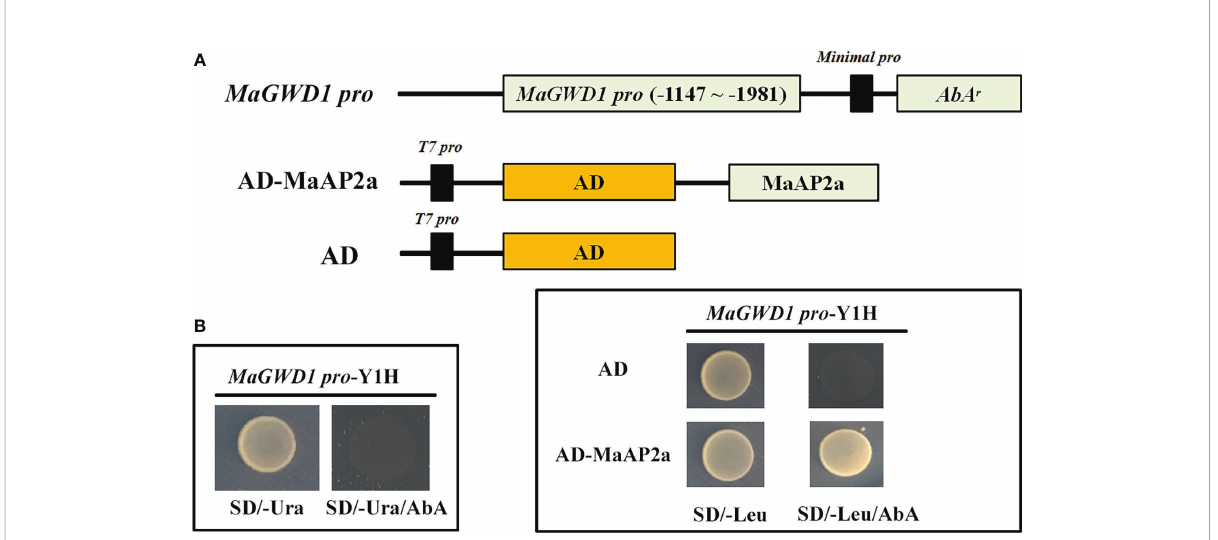
FIGURE 1 Binding of MaAP2a to MaGWD1 promoter by yeast one-hybrid (Y1H) assay. (A) Schematic diagram of the plasmids used in the Y1H assay. (B) Y1H analysis of MaAP2a binding to MaGWD1 promoters. Left: No survival of the bait ( MaGWD1- promoter Y1H) on synthetically de fi ned (SD) medium lacking uracil (Ura) in the presence of minimal inhibitory concentration of aureobasidin A (AbA). Right: Yeast growth assay after the Y1H reporter strains were transformed with plasmids carrying cassettes constitutively expressing Activation domain (AD)-MaAP2a effector or empty AD (negative control). Interaction was con fi rmed based on the normal growth of the transformed yeast on SD medium lacking leucine (Leu) in the presence of AbA.